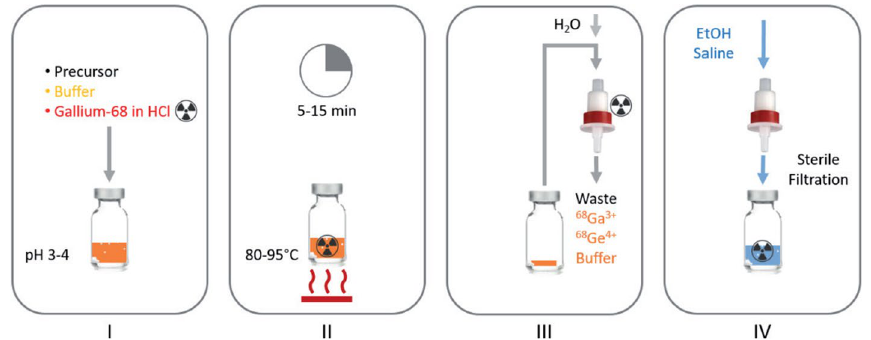
Fig. 2 The four main steps of the 68 Ga-radiolabeling procedure (Meisenheimer et al.